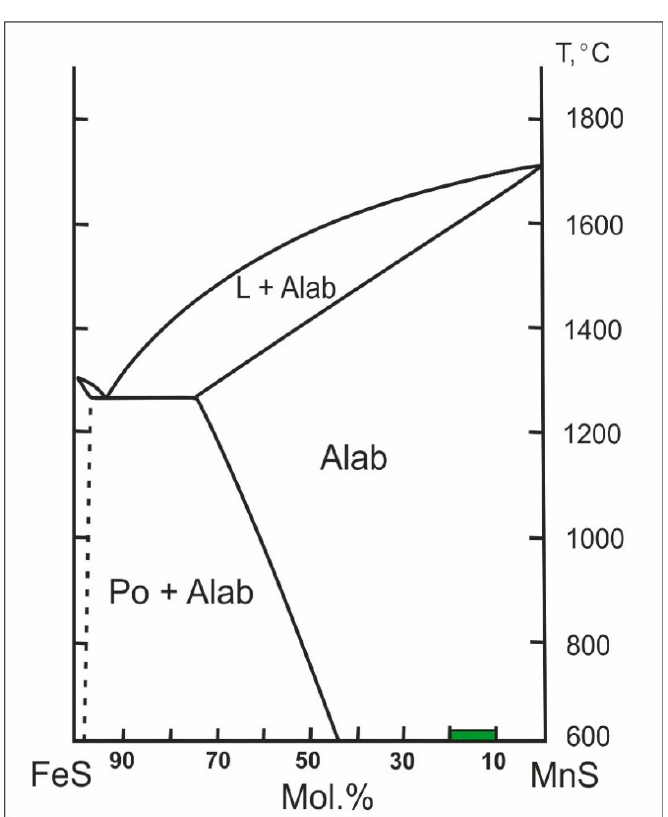
Figure 19. The FeS-MnS equilibrium diagram [102]. Compositional field of alabandite from spurrite marbles (green field) plotted using author data. Alab = alabandite, L = liquid, Po = pyrrhotite.